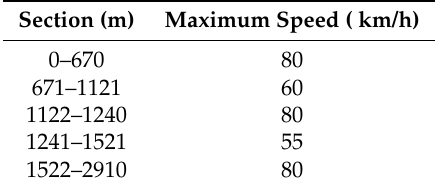
Table 9. The speed limit from Houyan to Qianguan. Section